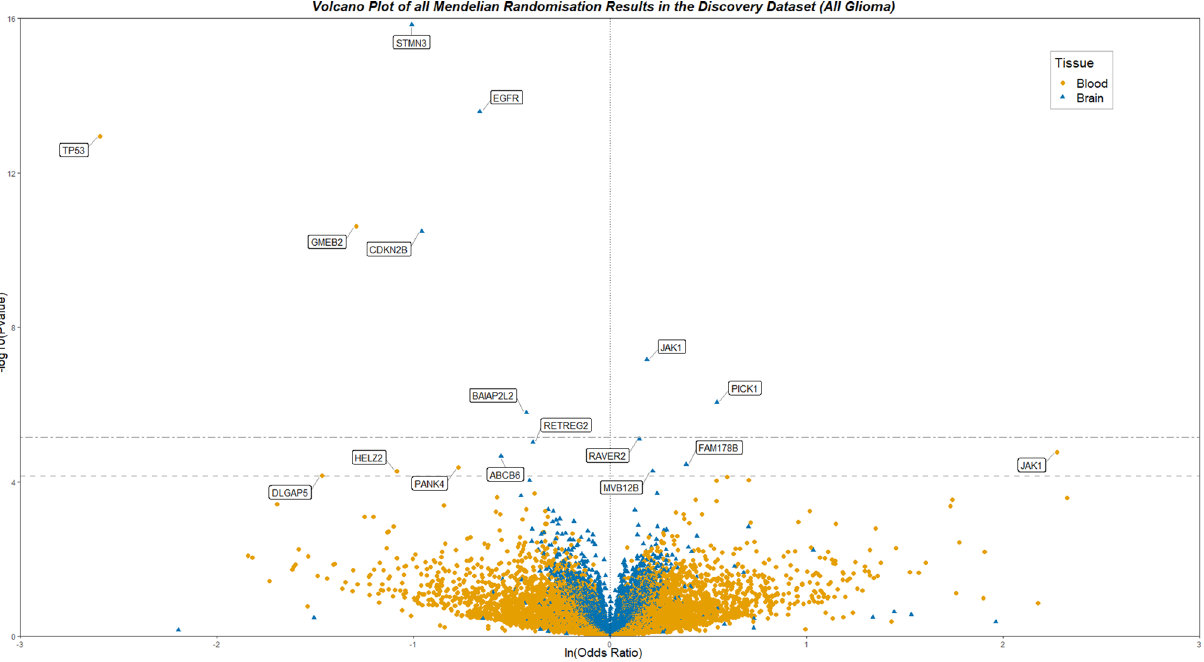
Figure 2. Volcano plot of all results from the main MR analysis of brain and blood eQTLs and all glioma. The horizontal dot-dashed line represents the Bonferroni-corrected P value threshold (P < 7.30 × 10 –6 ) and the horizontal dashed line is the suggestive P value threshold (P < 9.49 × 10 –5 ). Genes are labelled if they pass at least the suggestive threshold.